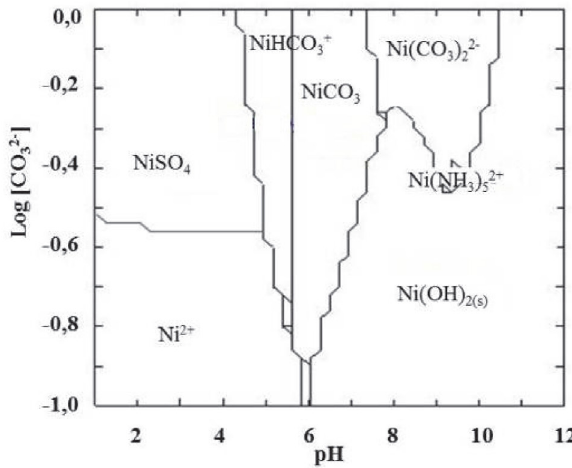
Figure 14. Predominance area diagram, Ni(II) 0.14M, [NH 3 ] 1.2M, [SO 42– ]